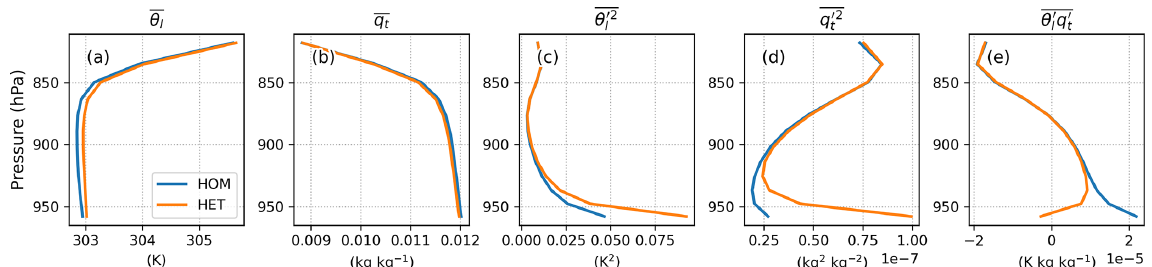
Figure 6. Profiles of CLUBB-predicted (a) liquid water potential temperature θ l , (b) specific humidity q t , (c) potential temperature variance θ (cid:48) l2 , (d) specific humidity variance q (cid:48) t2 and (e) temperature humidity covariance θ (cid:48) For clarity, the overline for atmospheric quantities hereafter denotes grid-cell mean.